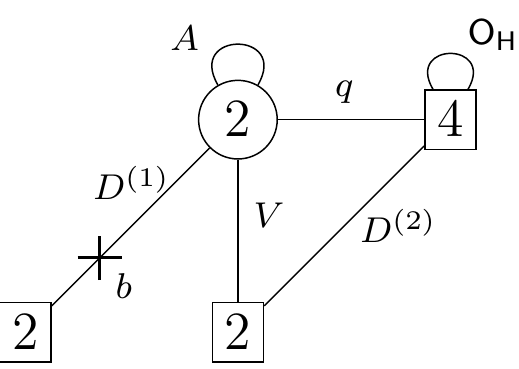
Figure 5 . Quiver diagram for the FE[USp(4)] theory. The arc on the SU(2) gauge node represents the field A in the antisymmetric representation of the gauge symmetry, i.e. a gauge singlet, while the arc on the USp(4) flavor node represents the field O in the traceless antisymmetric representation H of the flavor